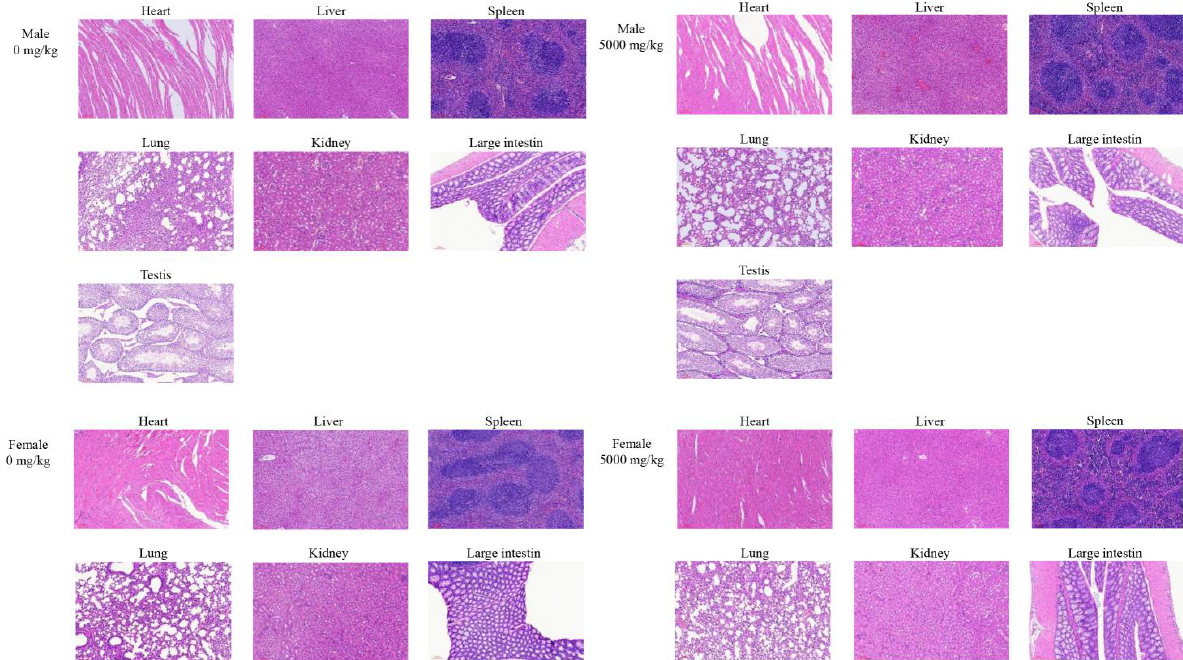
Figure 7. Histological examination. The male and female mice were fed with a fixed dose of 0 mg/kg BW and 5000 mg/kg BW of cMORP for the single-dose acute oral toxicity study ( ×